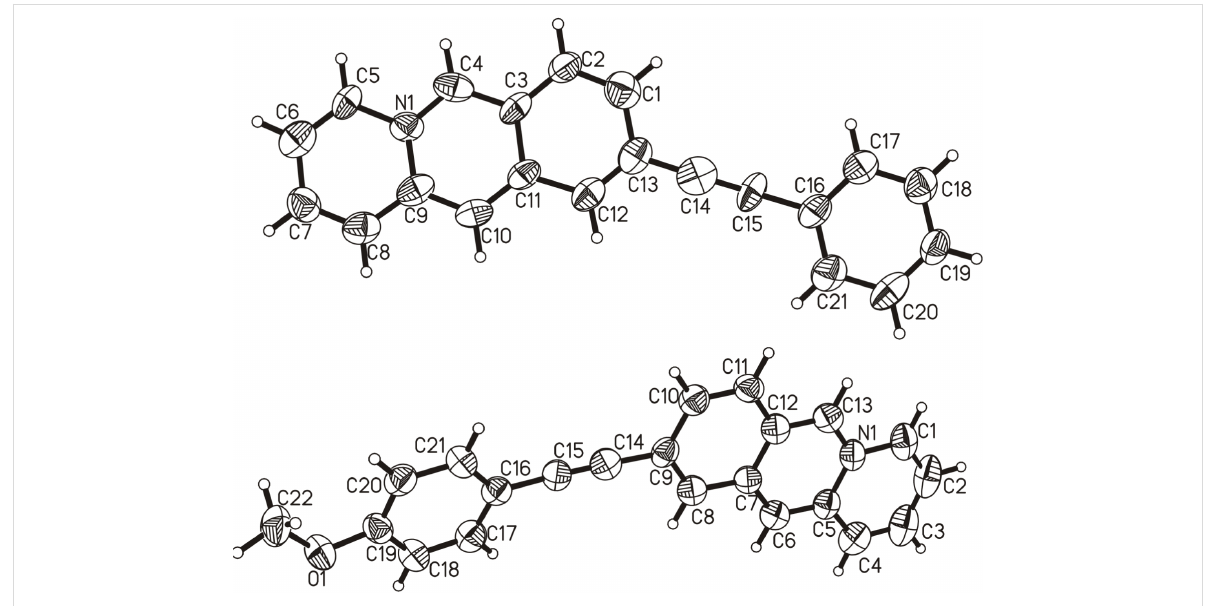
Figure 2: Molecular structures of derivatives 2a (top) and 2b (bottom) in the solid state. Ellipsoids are shown at the 50% probability level. The counter anions and solvent molecule were omitted for